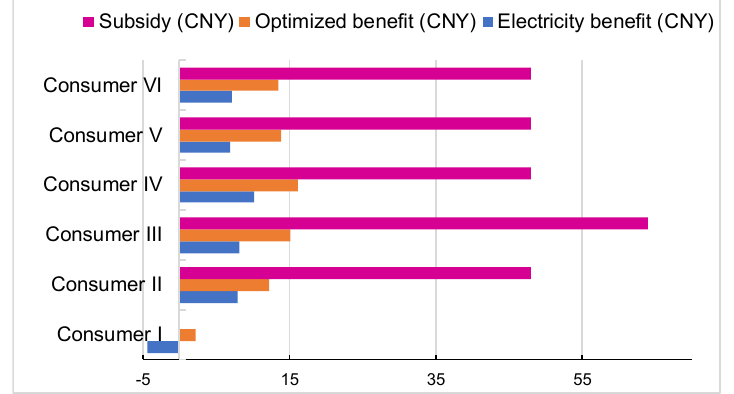
Figure 11. Daily electricity benefits of consumers .